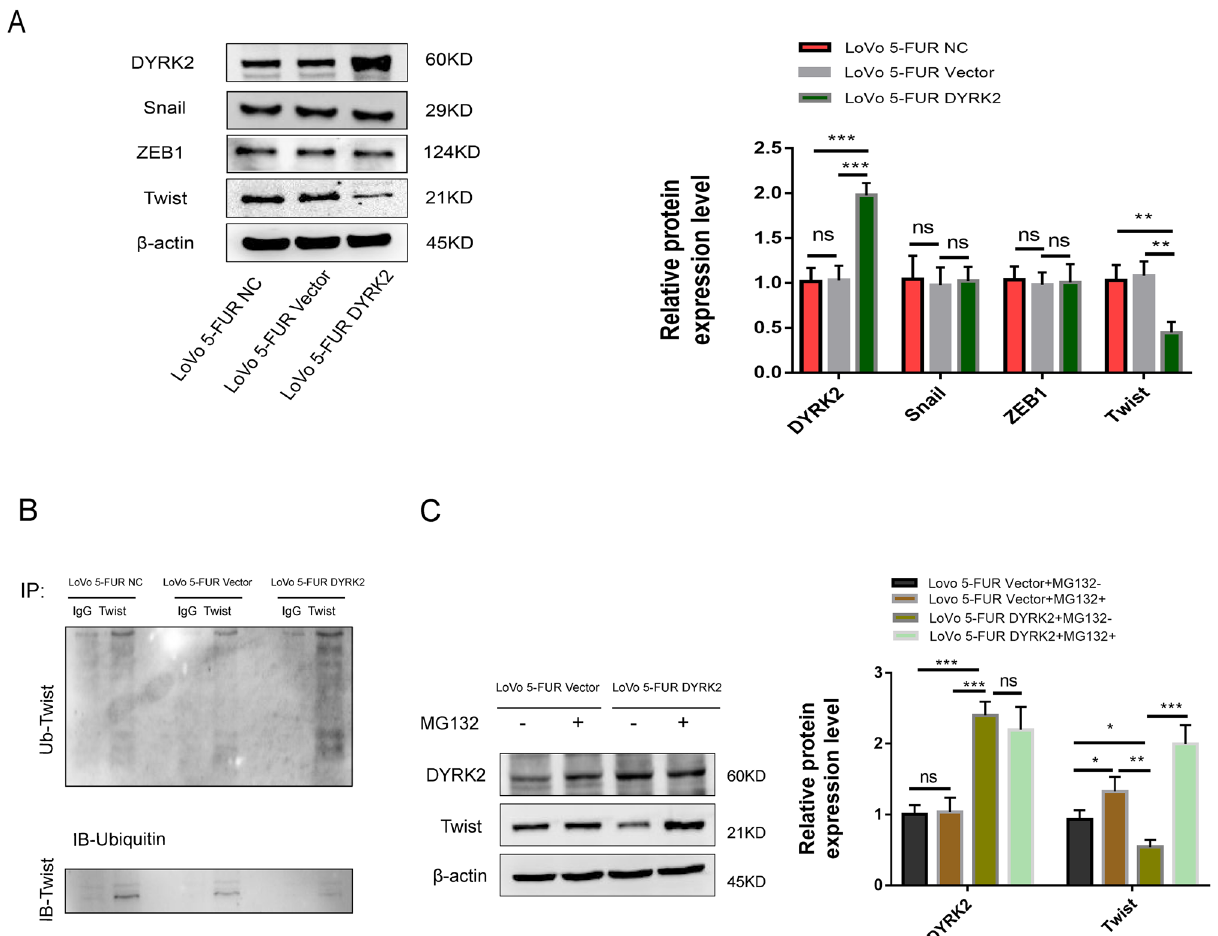
Figure 6. DYRK2 promotes ubiquitin-mediated proteasomal Twist degradation. ( A ) Western blotting was used to assess DYRK2, Snail, ZEB1 and Twist levels in LoVo 5-FUR cells transfected with DYRK2 overexpression or control lentiviruses. ( B ) Anti-Twist and anti-ubiquitin were used for immunoprecipitation. ( C ) LoVo5-FUR cells transfected with DYRK2 overexpression or control vectors were treated for 4 h with MG-132 (10 μM), after which Western blotting was used to assess DYRK2 and Twist protein levels. * P < 0.05, ** P < 0.01, *** P < 0.001, ns not